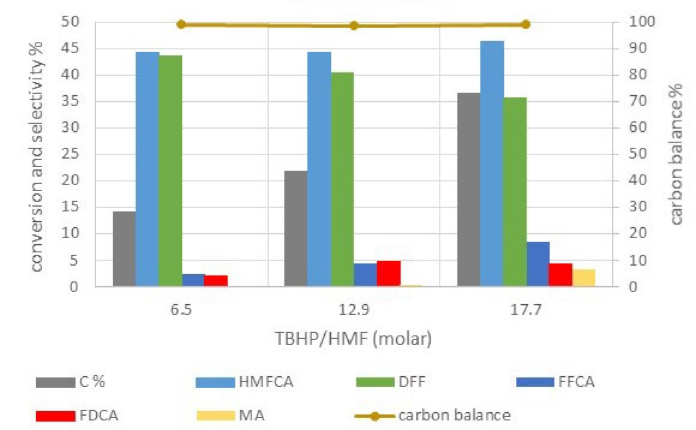
Figure 9. Conversion of HMF and selectivity of products in the absence of a catalyst as a function of